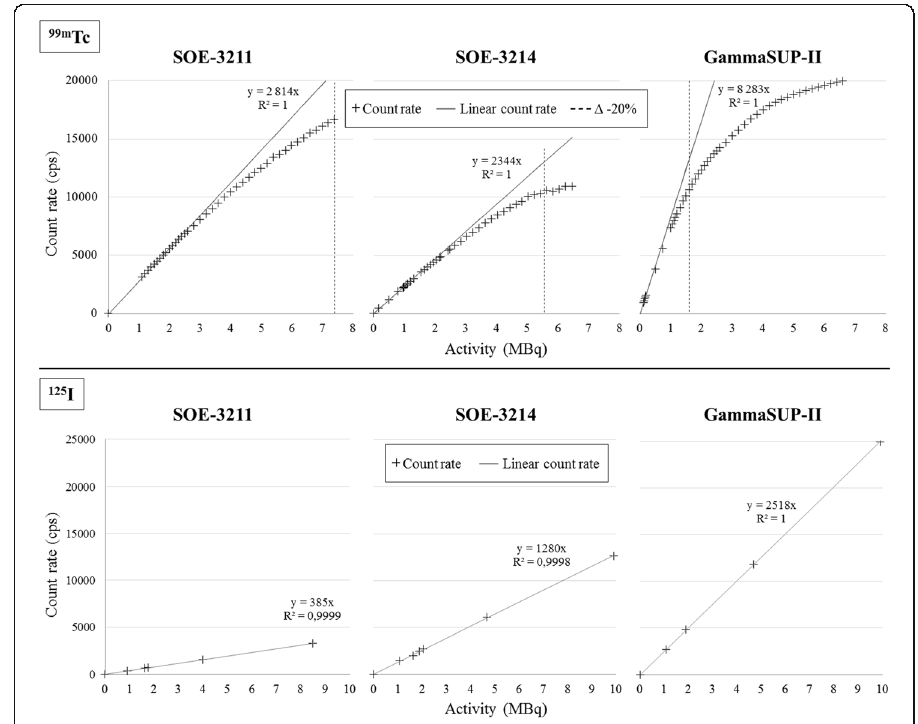
Fig. 6 Count rate capability of the three probes for 99m Tc and 125 I sources at 10-mm depth